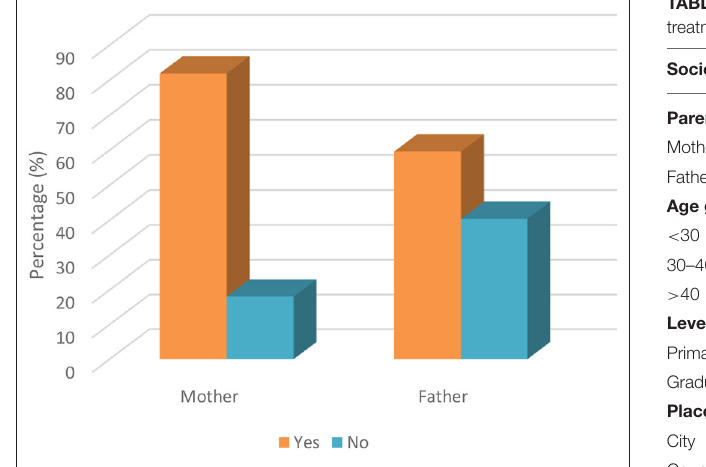
FIGURE 3 | Parents’ responses to whether they are concerned about taking their children to dental treatment during COVID-19 based on parenthood relationship.